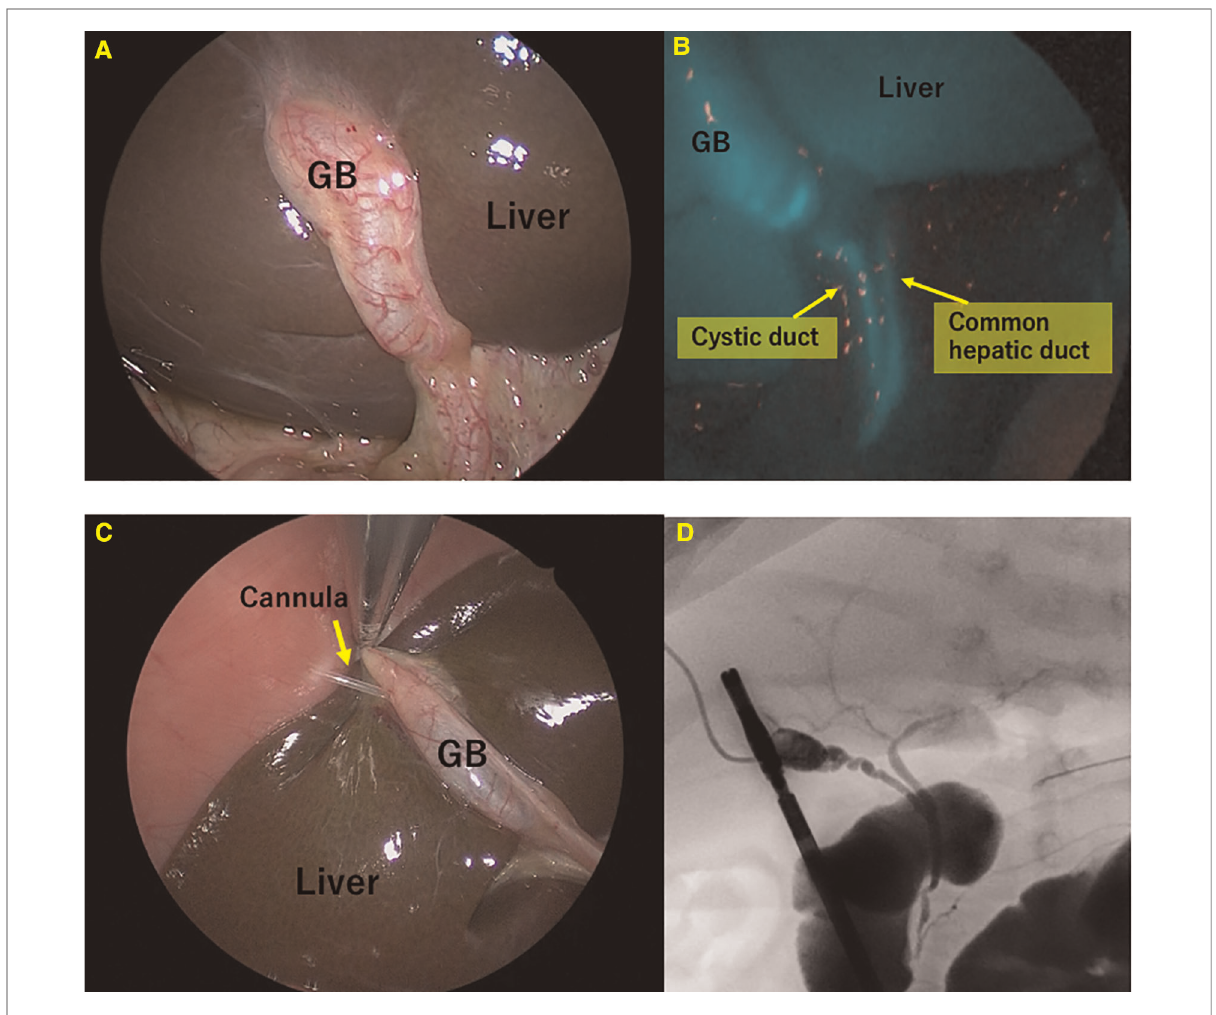
FIGURE 1 Fluorescence and conventional cholangiography for non-biliary atresia (BA) patients. ( A ) Normal view. ( B ) Fluorescence cholangiography. (C) Cannulation of the gallbladder. ( D ) Conventional